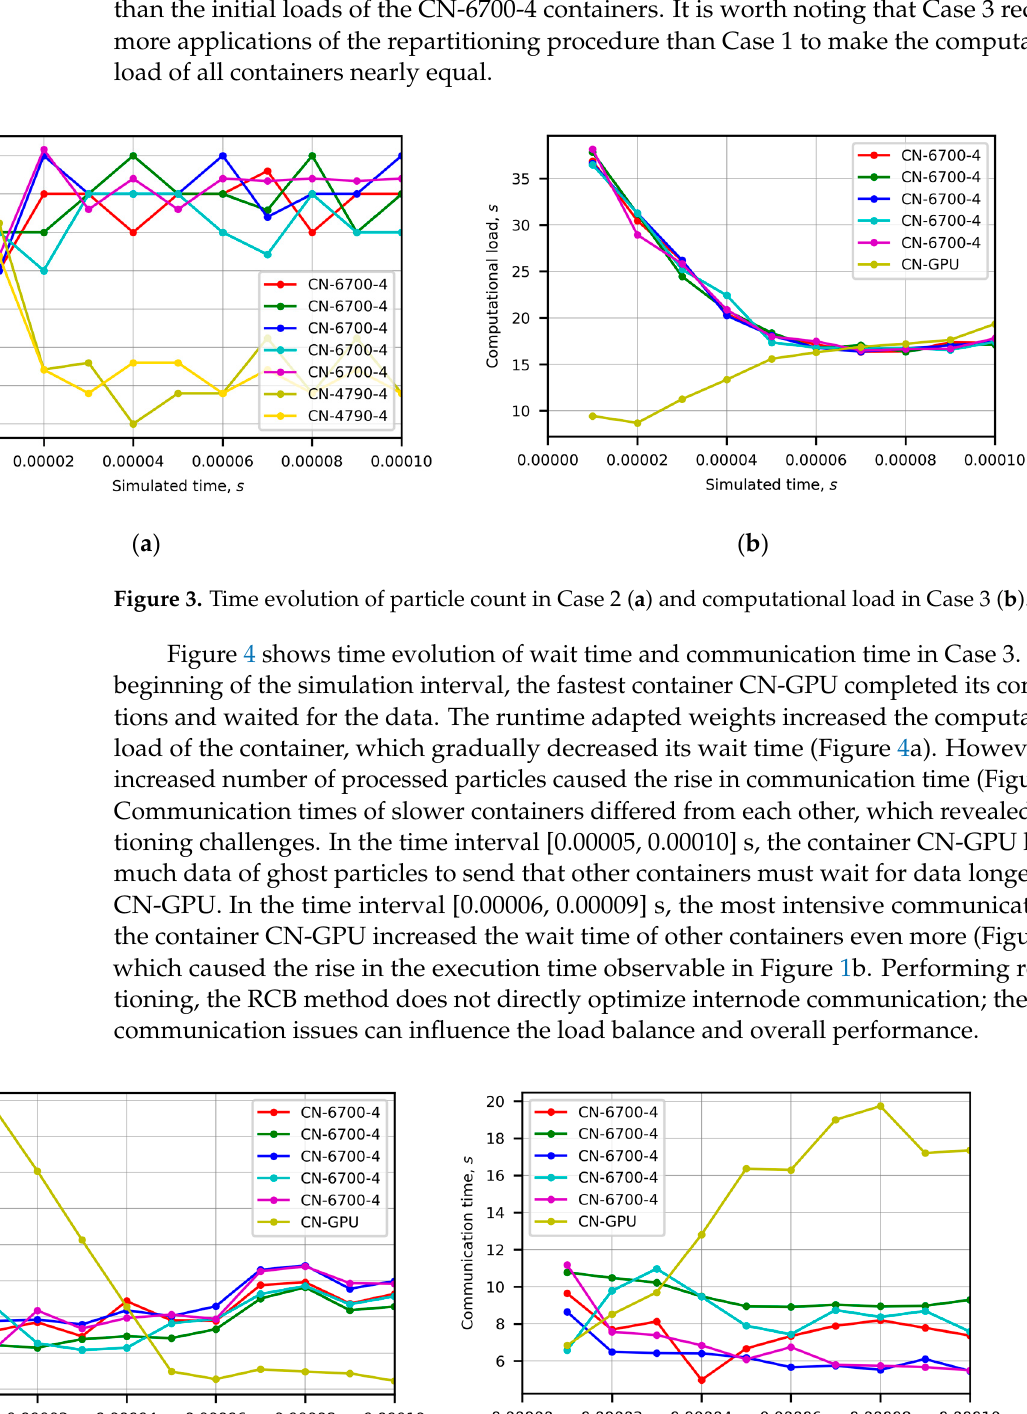
Figure 2. Time evolution of the computational load ( a ) and weights ( b ) in Case 1.